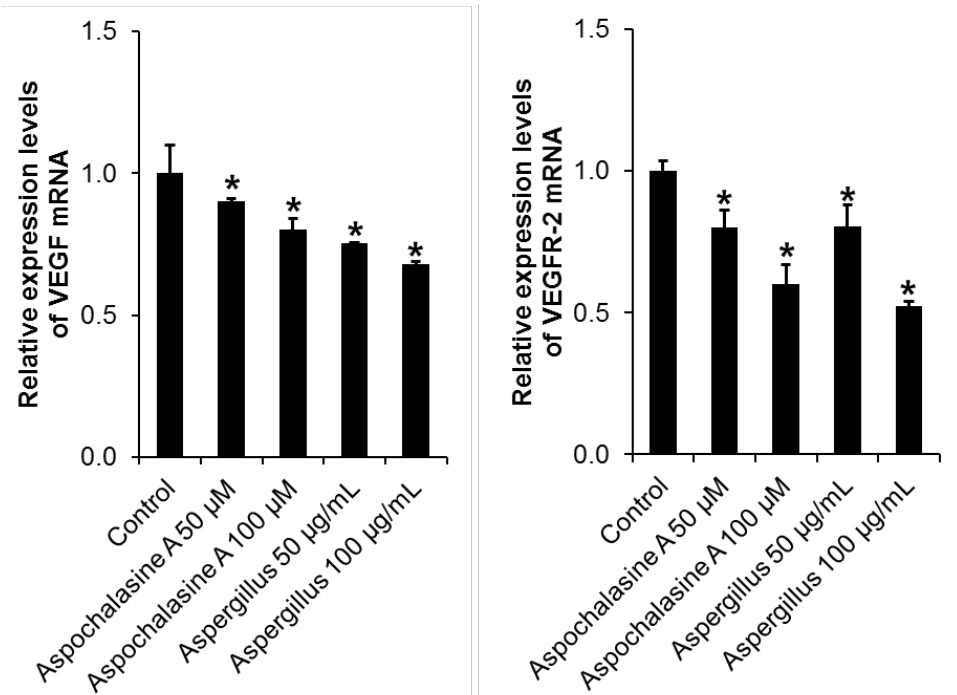
Figure 8. Effect of Aspergillus extract and aspochalasine A on VEGF and VEGFR-2 mRNA expressions in HUVECs. Total RNA was extracted from the Aspergillus extract and aspochalasine A-treated HUVECs, and human VEGF-A mRNA or human VEGFR-2 mRNA expression were analyzed by reverse transcriptase (RT)-PCR. GAPDH was used as an internal control. Data are expressed as means ± SEM. Similar results were obtained from three independent experiments.